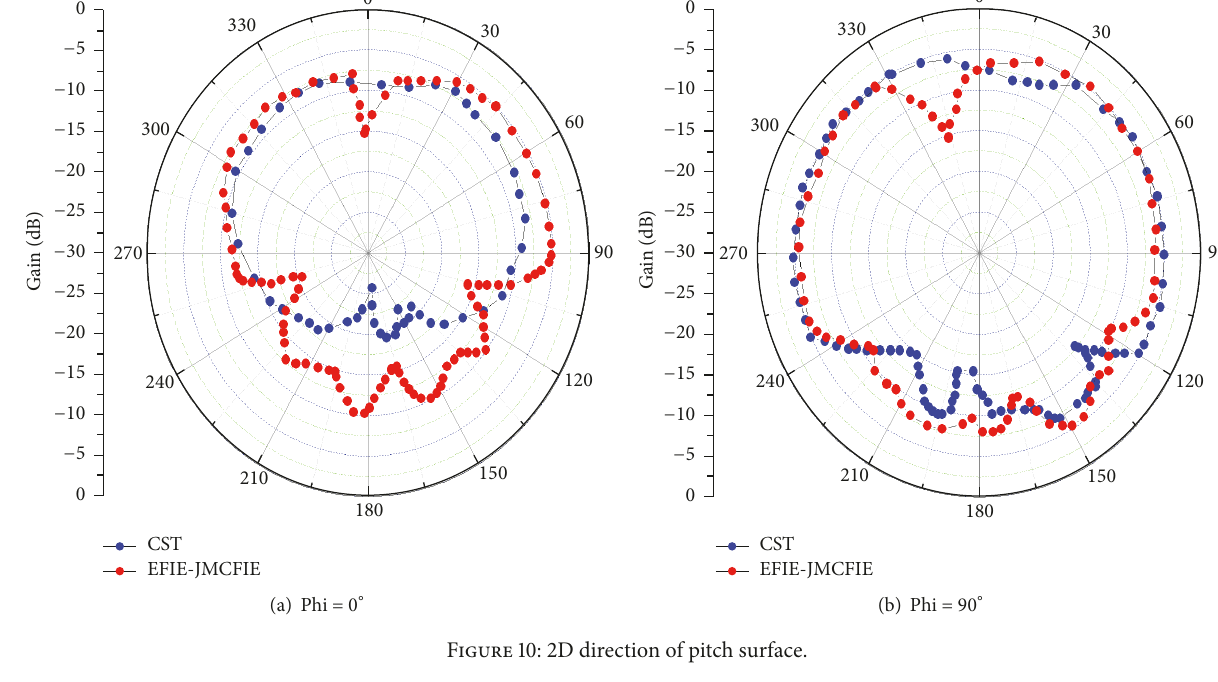
Figure 10: 2D direction of pitch surface.